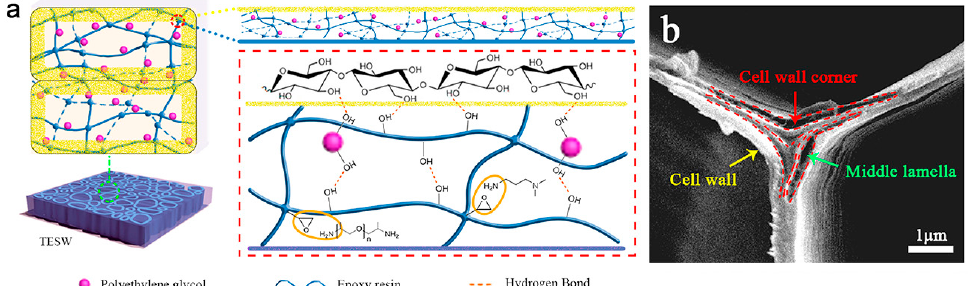
Figure 7. ( a ) Illustration of hydrogen bonding mechanism in TESW and ( b ) cross-sectional image of DW. TESW = transmittance energy storage wood. Reproduced with permission from reference [43], copyright 2021, Elsevier B.V.